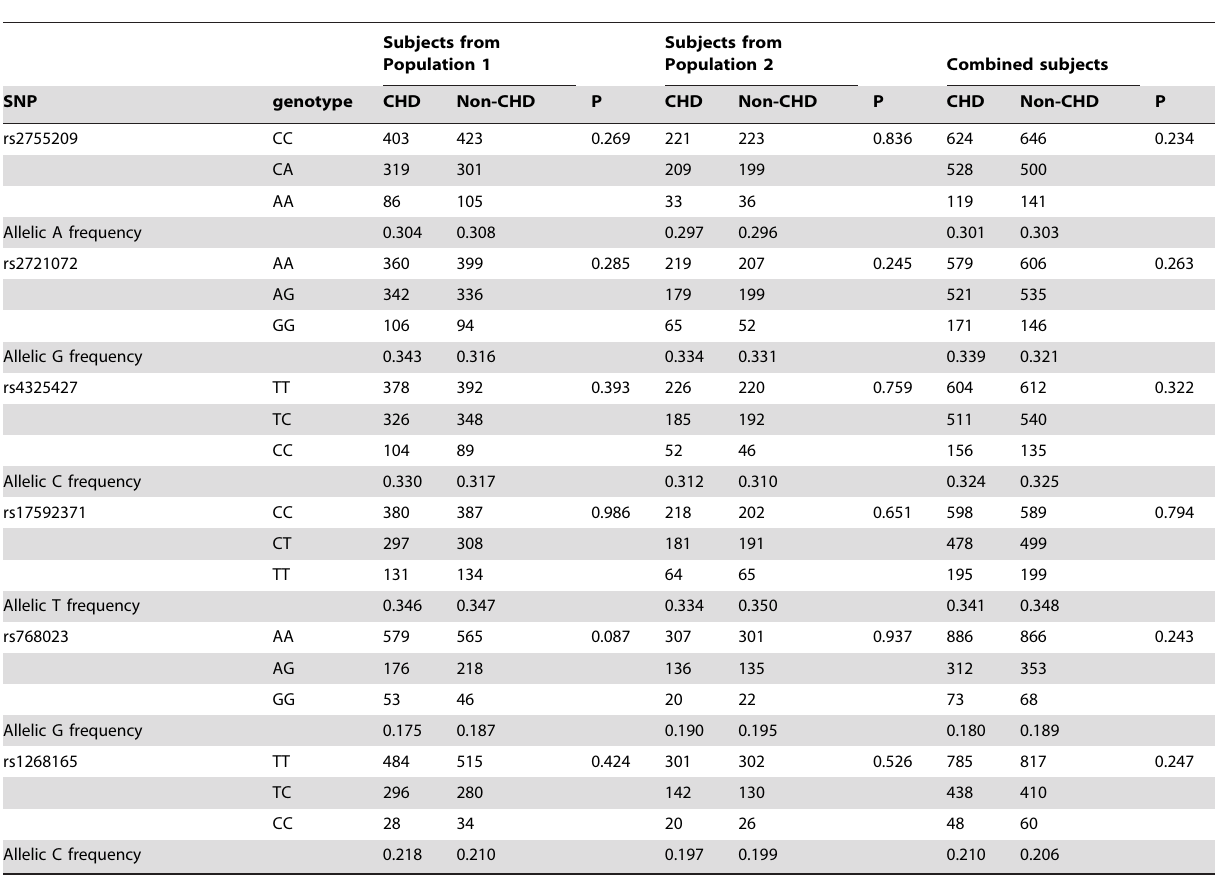
Table 3. Frequency of FoxO1 and FoxO3 polymorphism in CHD from two different populations.